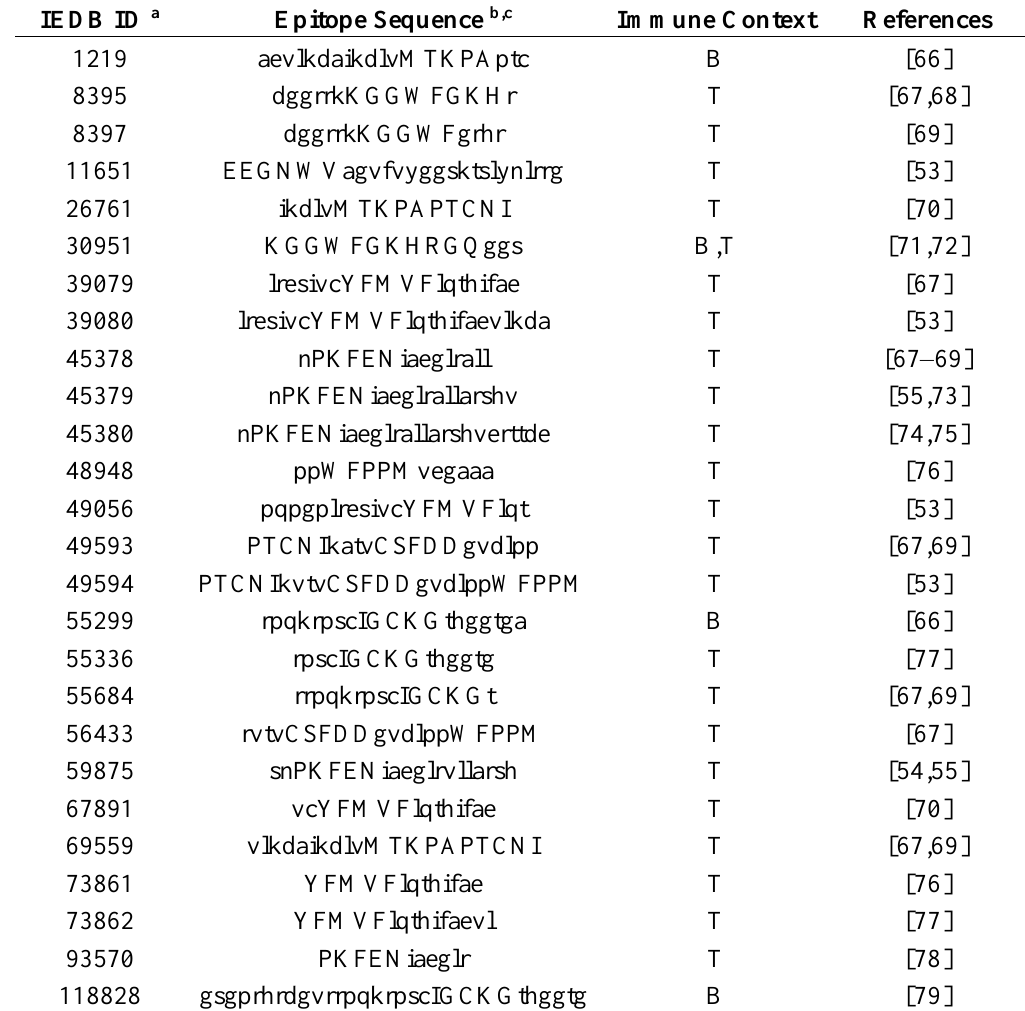
Table 2. Thirteen out of the 15 pentapeptides unique to EBV EBNA1 and absent in the human proteome, are distributed among 26 EBV EBNA1-derived epitopes are immunoreactive in humoral and/or cellular immunoassays.